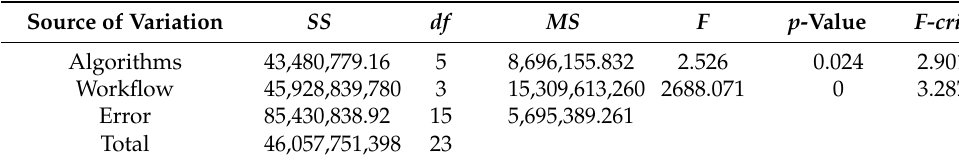
Table 11. Two way ANOVA descriptive results for Epigenomics Workflow.